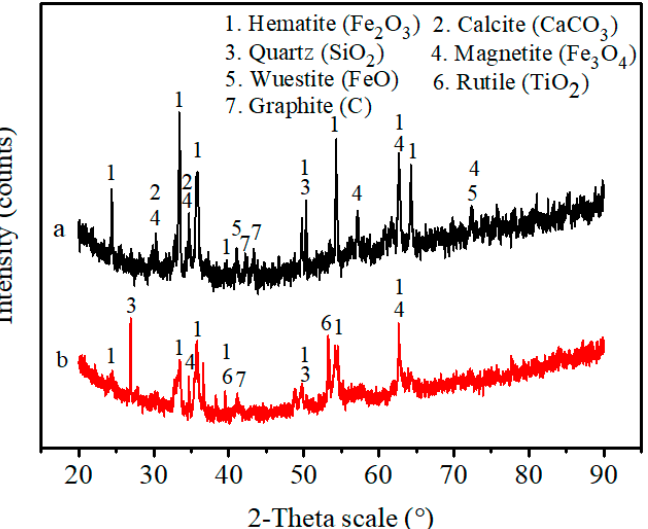
Figure 14. X ‐ ray diffraction patterns for ( a ) the mixture of sample A, binder and water; ( b ) the mixture of sample B, binder and water. mixture of sample B, binder and